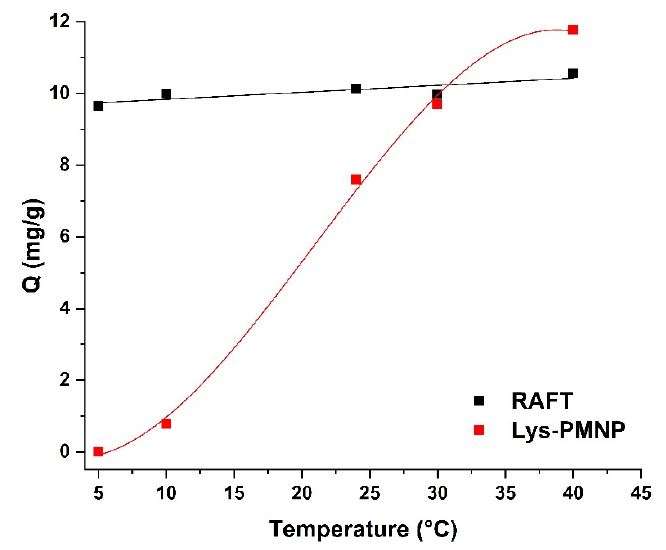
Figure 8. Effect of temperature on the lysozyme binding capacity of Lys-PMNPs and Fe 3 O 4 @SiO 2 @RAFT particles. (1.6 mg/mL Lys-PMNP or Fe 3 O 4 @SiO 2 @RAFT particles were incubated with 50 µg/mL lysozyme in 50 mM PB, pH 7).